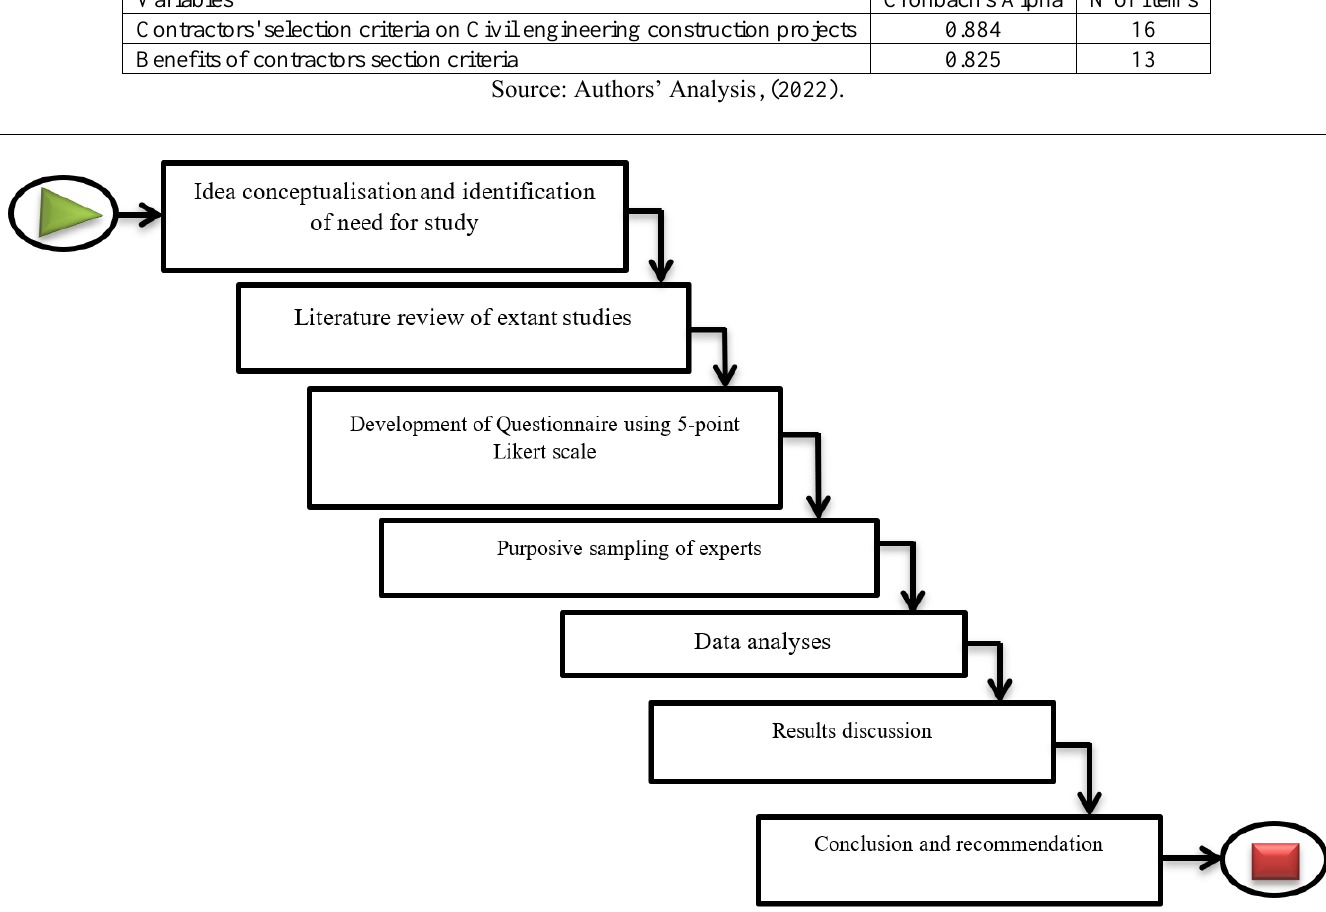
Figure 1: Study methodological flow chart.